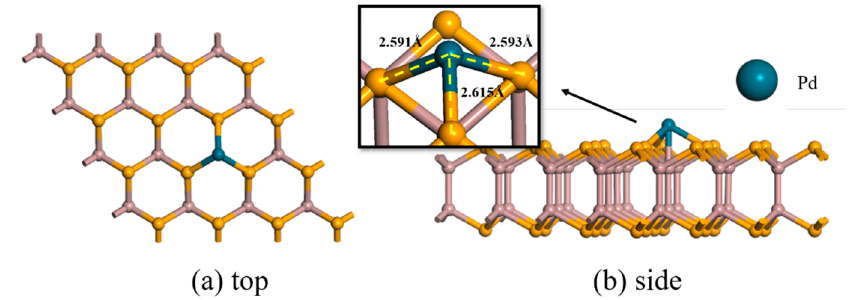
Figure 3. Geometric model of the Pd-GaSe monolayer.